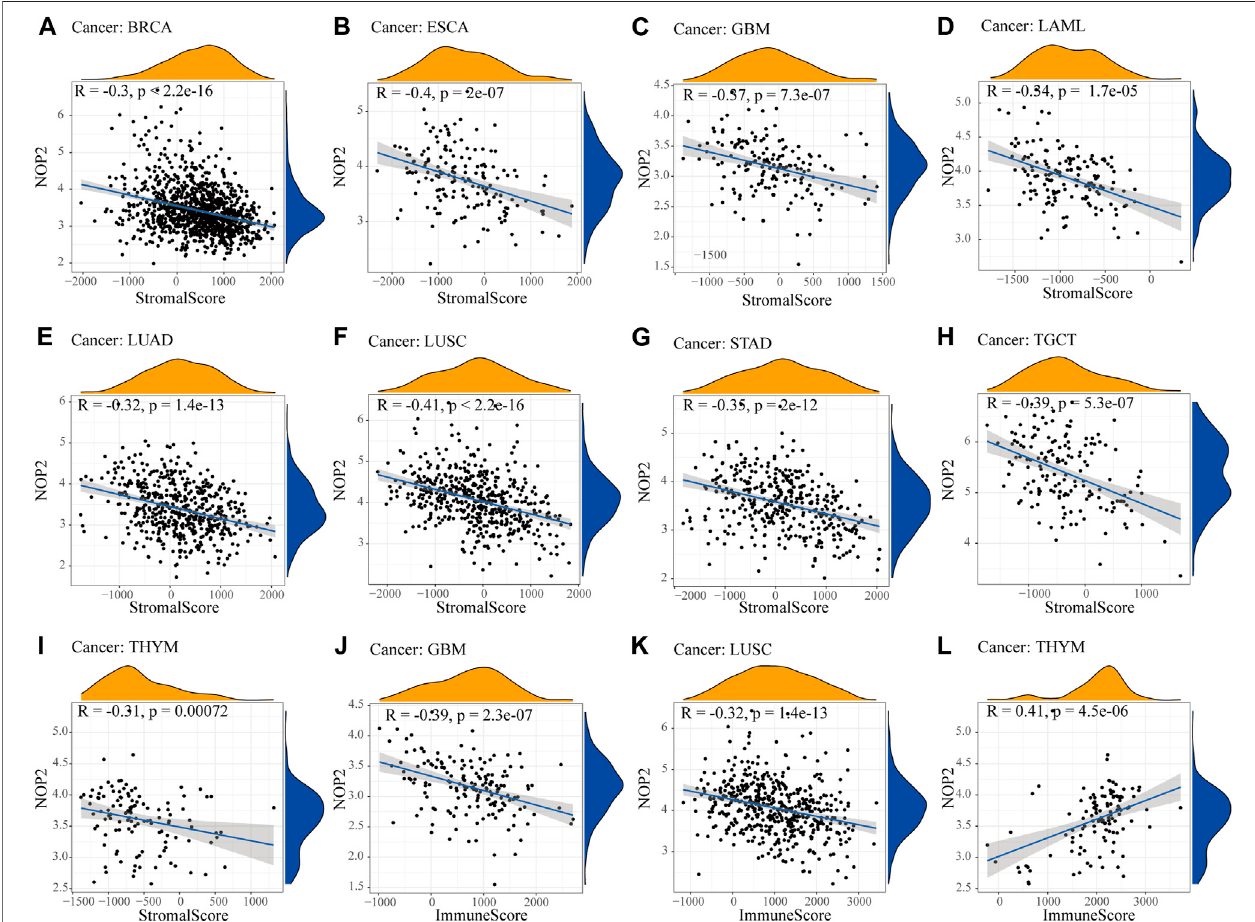
FIGURE4| Correlation betweenNOP2 expression andtheESTIMATEscore.ThecorrelationplotsareillustratedifR > 0.4and p < 0.05. (A – I) Correlation between NOP2 expression and stromal score in BRCA (A) , ESCA (B) , GBM (C) , LAML (D) , LUAD (E) , LUSC (F) , STAD (G) , TGCT (H) , and THYM (I) . (J – L) Correlation between NOP2 expression and immune score in GBM (J) , LUSC (K) , and THYM (L) .